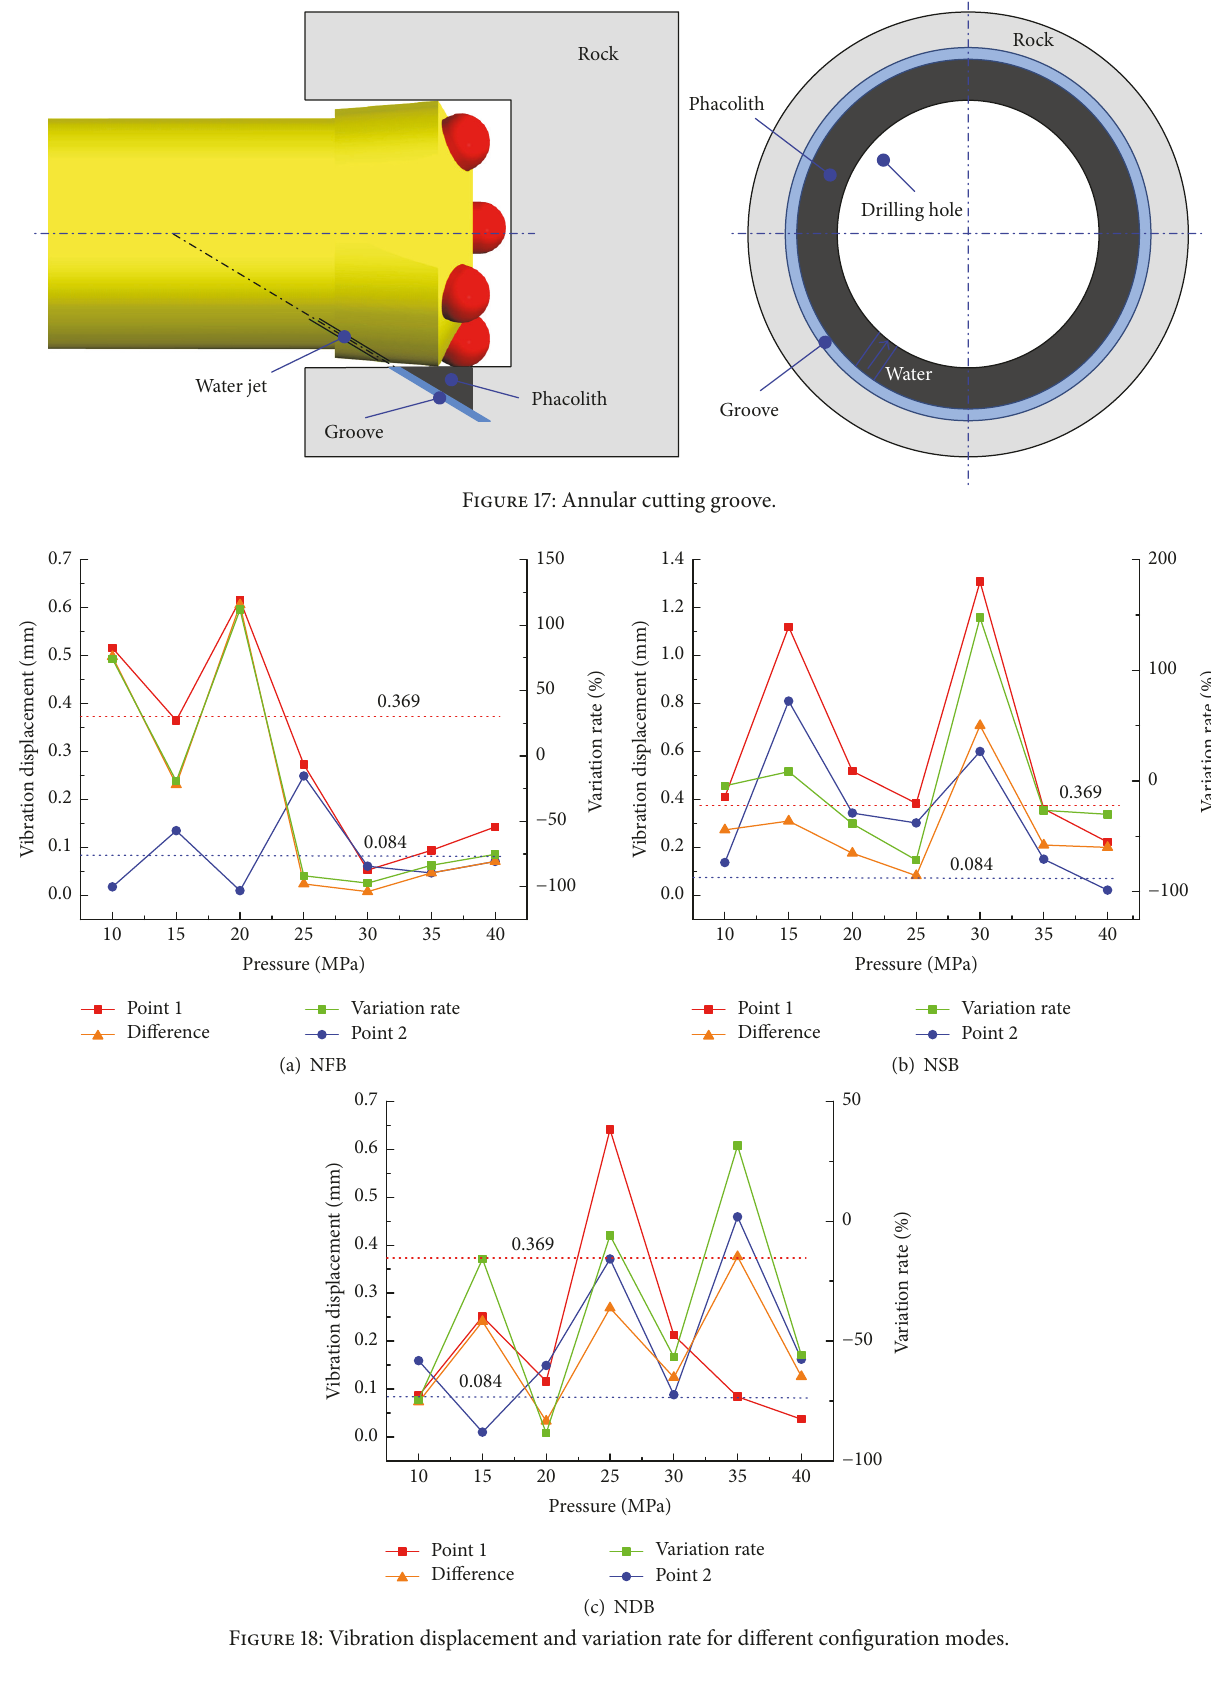
Figure 18: Vibration displacement and variation rate for different configuration